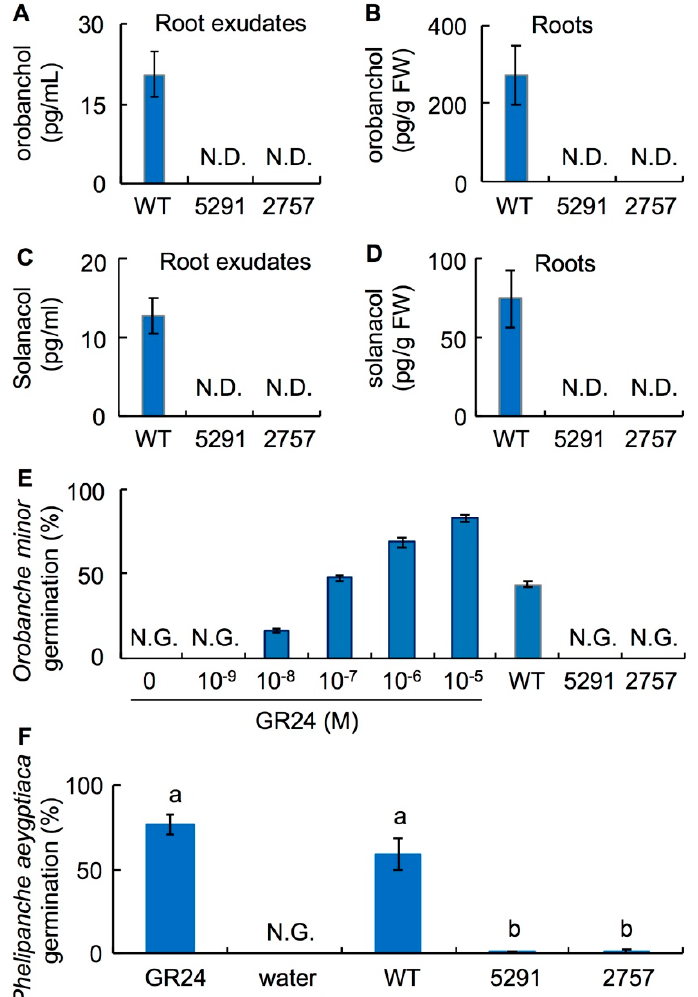
Figure 2. Orobanchol and solanacol levels in root exudates and roots of WT and lines 5291 and 2757, and germination assays with root-parasitic plants. ( A ) n = 6. ( B ) n = 5. ( C ) n = 10. ( D ) n = 5. ( E , F ) Germination assays using ( E ) Orobanche minor ( n = 6) or ( F ) Phelipanche aegyptiaca . Error bars, S.E.; N.D., not detected; N.G., no germination.